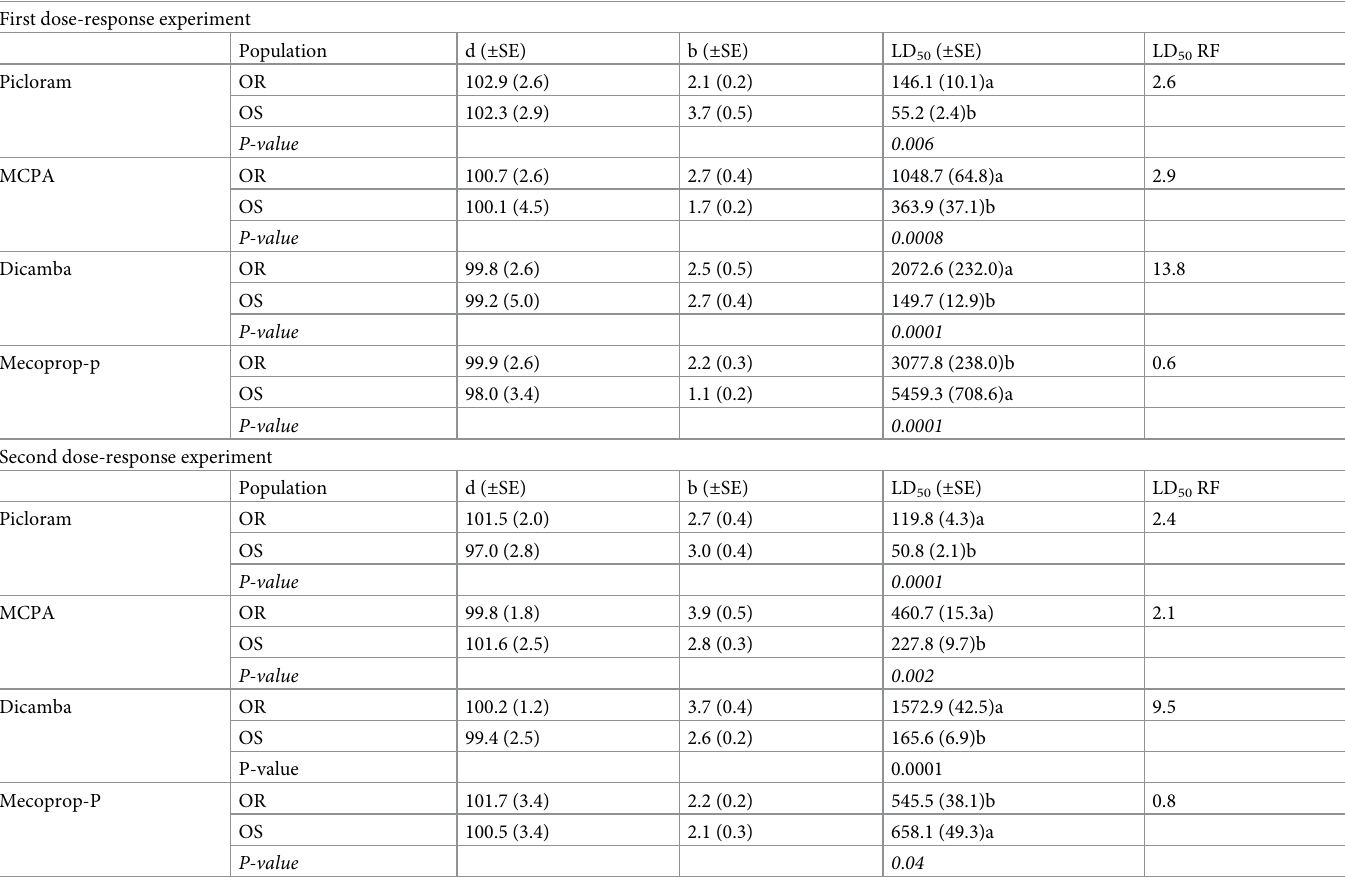
Table 3. Parameters (see footnote) estimated from the four-parameter log-logistic model analysis of picloram, MCPA, dicamba and mecoprop dose-response exper- iments for clopyralid-resistant (OR) and susceptible (OS) populations evaluated at 4 weeks after treatment. First dose-response